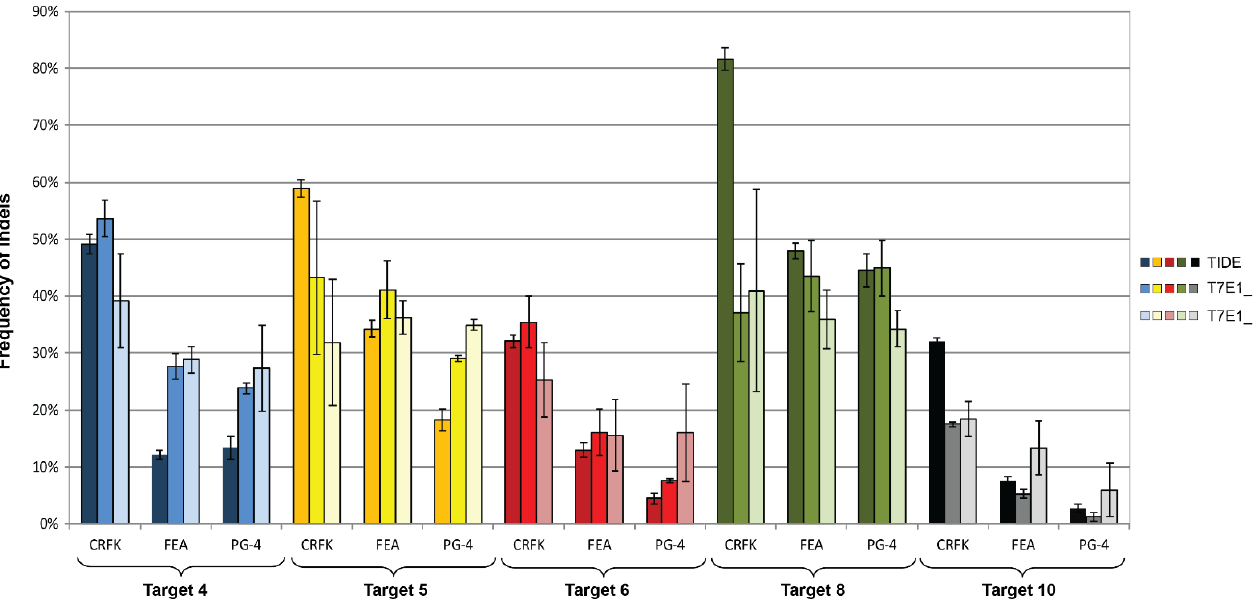
Figure 7. Comparison of CRISPR/ Sa Cas9 activity leading to indels after transduction. After CRISPR/ Sa Cas9 transduction using the AAV-DJ vectors vT4 (Target 4, blue), vT5 (Target 5, yellow), vT6 (Target 6, red), vT8 (Target 8, green), and vT10 (Target 10, grey); NHEJ events were compared using TIDE and the T7E1 assays. T7E1 efficiency was determined by parallel capillary electrophoresis using a fragment analyzer (FA) and band intensity comparison on an agarose gel. Transductions were performed on CRFK, FEA, and PG-4 cells. Data represent the mean of three biological replicates ± standard deviation. Table 4. In vitro cleavage of FeLV provirus at target sites after transduction.